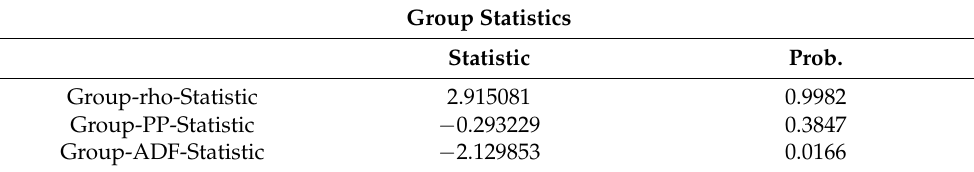
Table 5. Group Statistics.